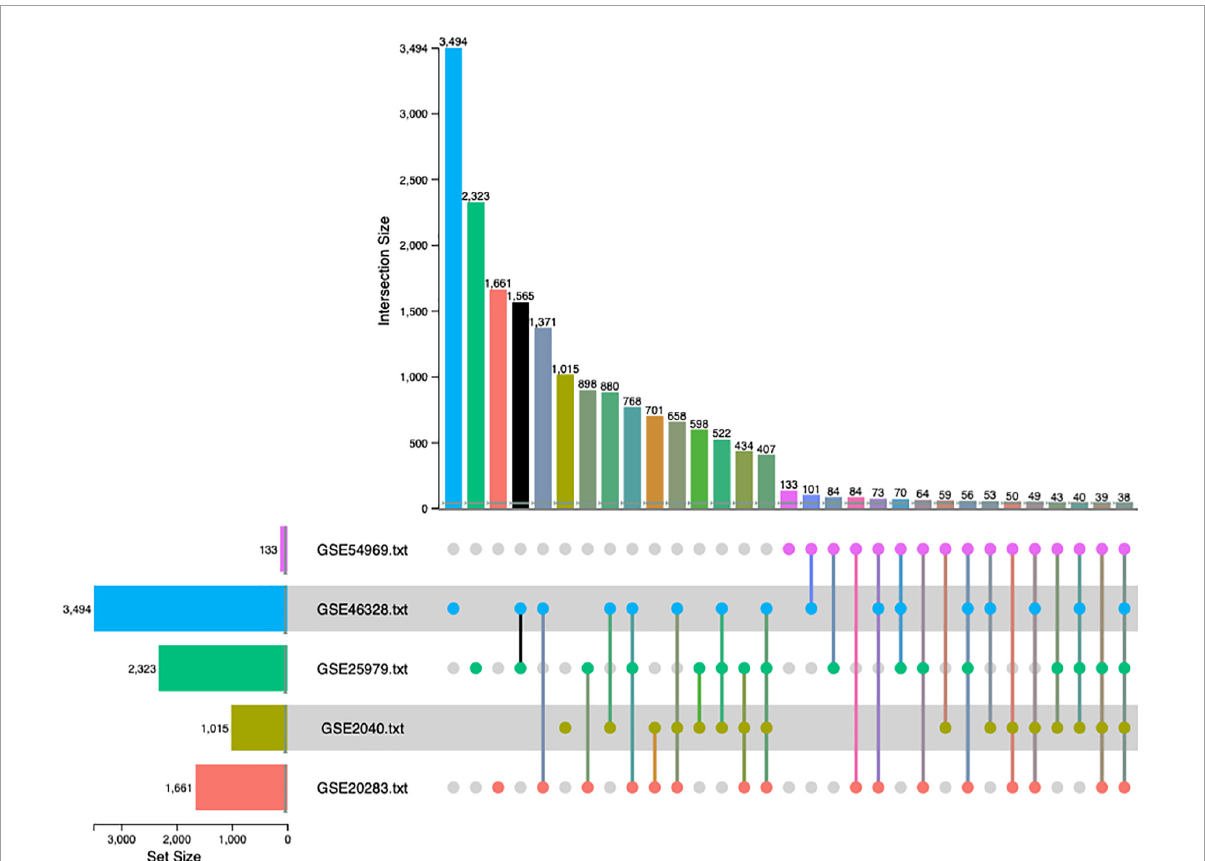
FIGURE2 Up-set plot detailing the number of common elements among microarray datasets. Horizontal bars indicate the number of significant differentially expressed genes (DEGs) in each study. The vertical bars indicate the common elements in the sets, indicated with dots under each bar. The single points represent the number of unique elements in each group. There were 38 genes commonly dysregulated in the five